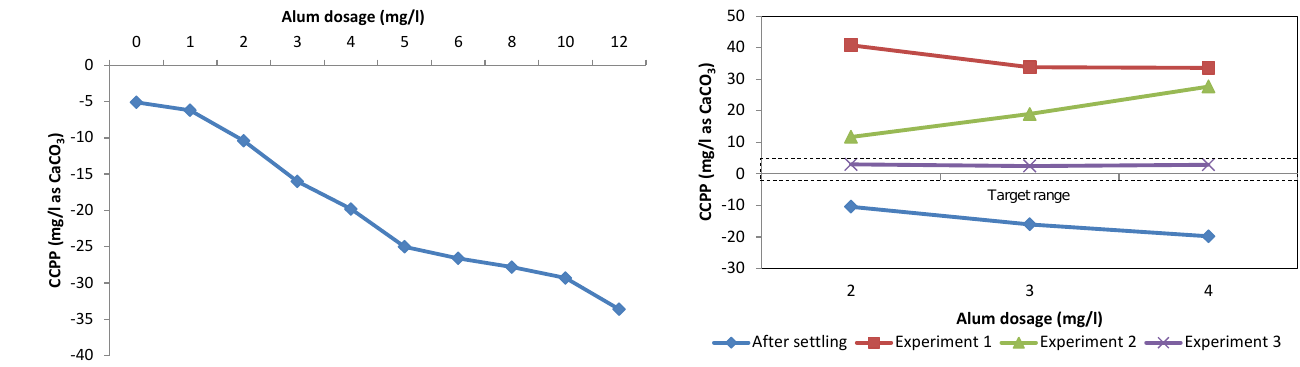
Figure 8. Impact of alum dosage on CCPP of treated water. Figure 9.